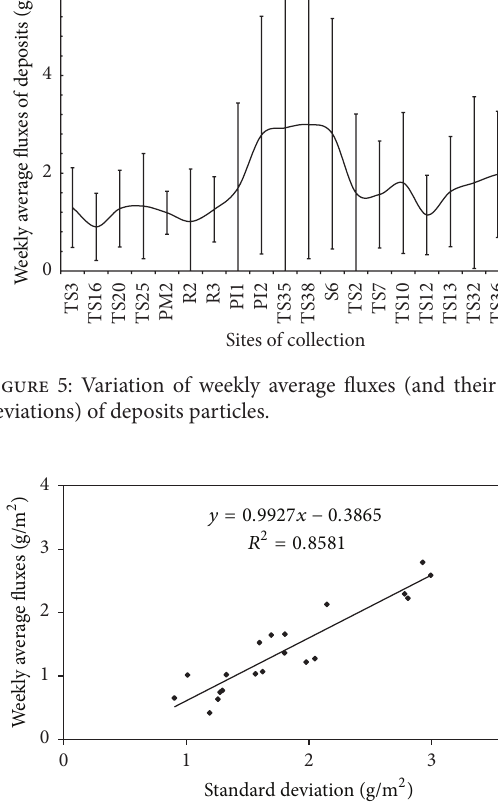
Figure 6: Linear regression between the weekly averages fluxes of deposits and their standard deviations.